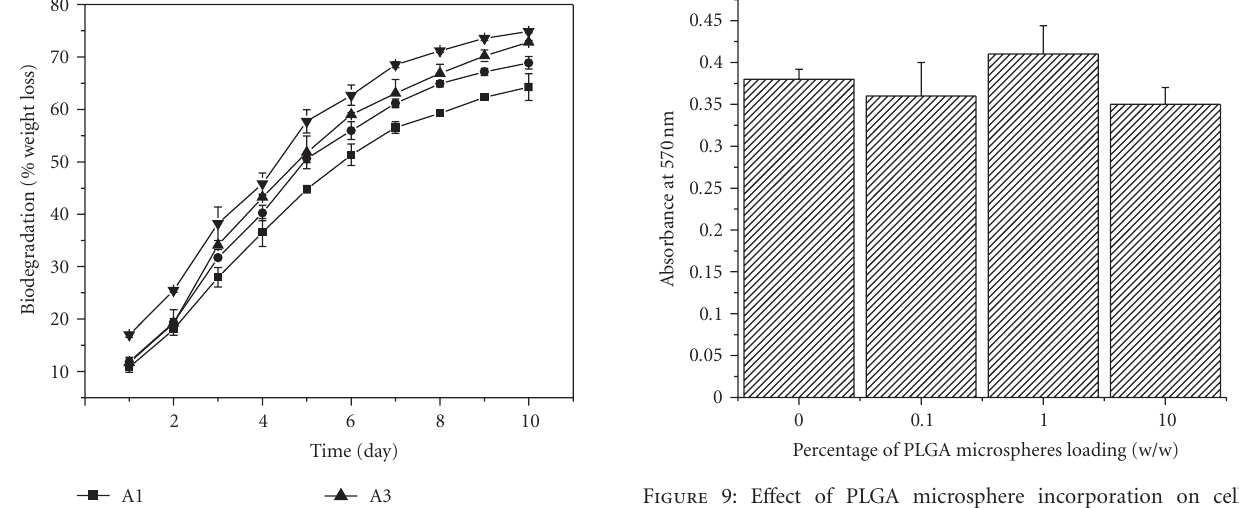
Figure 9: E ff ect of PLGA microsphere incorporation on cell adhesion after 4 hours of cell seeding. Values are mean ± S.D. ( n = 3).